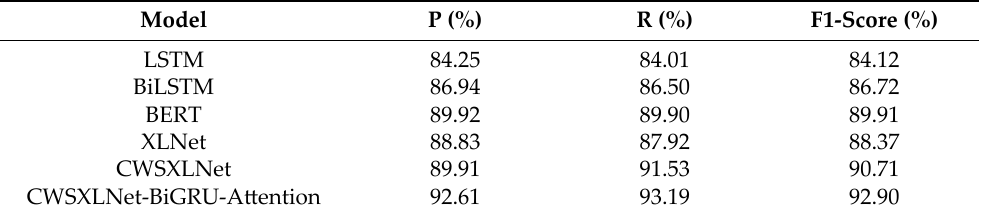
Table 5. ChnSentiCorp dataset experimental results.